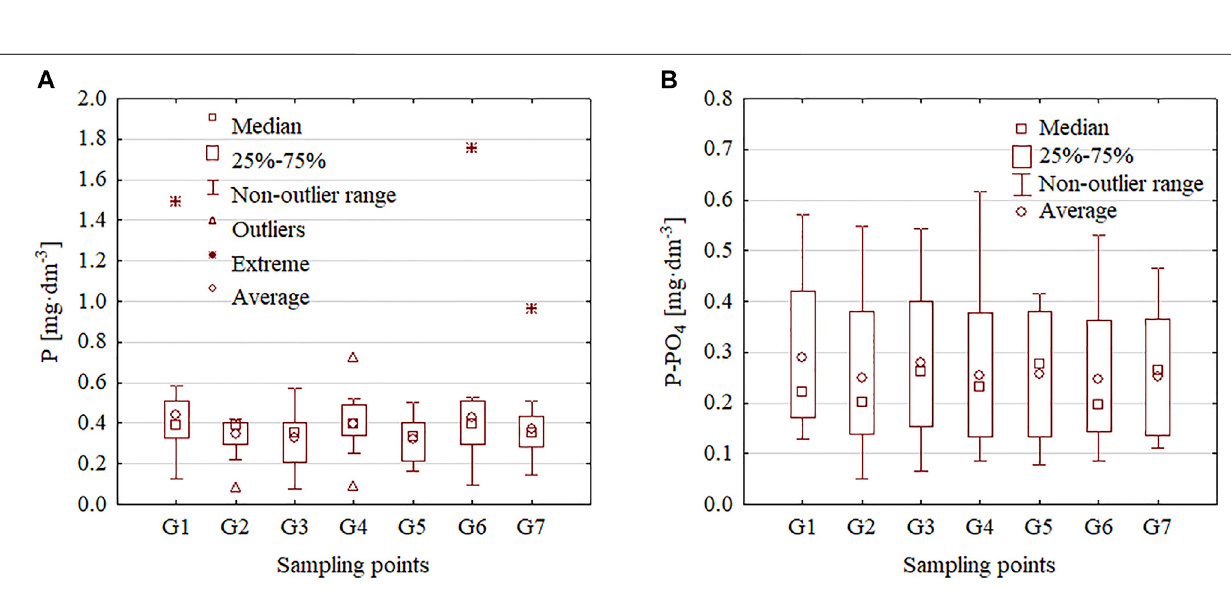
Frontiers in Environmental Science |